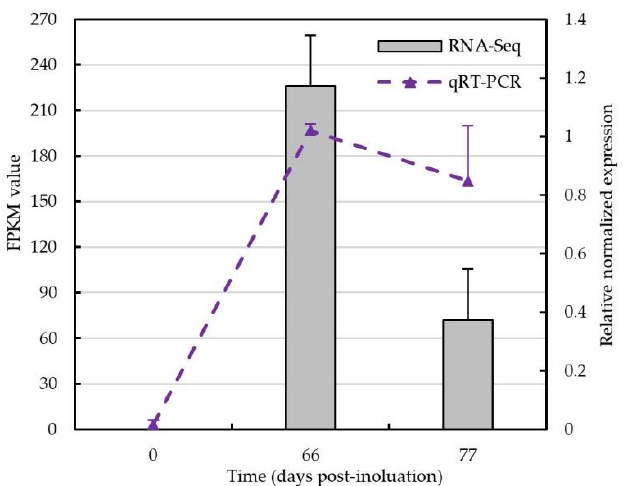
Figure 4. The expression level of the candidate effector gene Cluster-3395.48660 . The expression level of the candidate effector gene Cluster-3395.48660 was test in 0 dpi, 60 dpi and 77 dpi planta samples by qRT-PCR. The combination of EF1 , EF2 and α -TUB were used for normalization. Bars represented FPKM of the RNA-Seq data; dotted lines represent relative expression levels obtained by qRT-PCR; error bars indicate standard error.